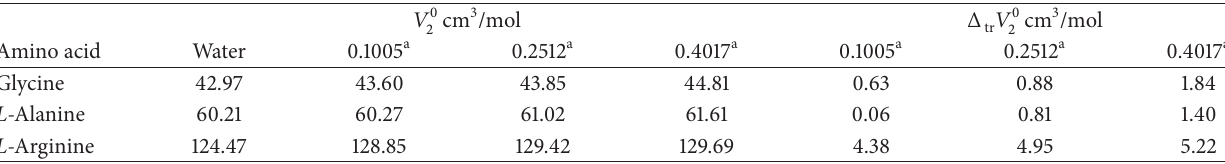
Table 3: Standard partial molar volumes and transfer partial molar volumes of glycine, L -alaine, and L -arginine in aqueous solution of hydroxylamine sulfate at T = 298.15 K.